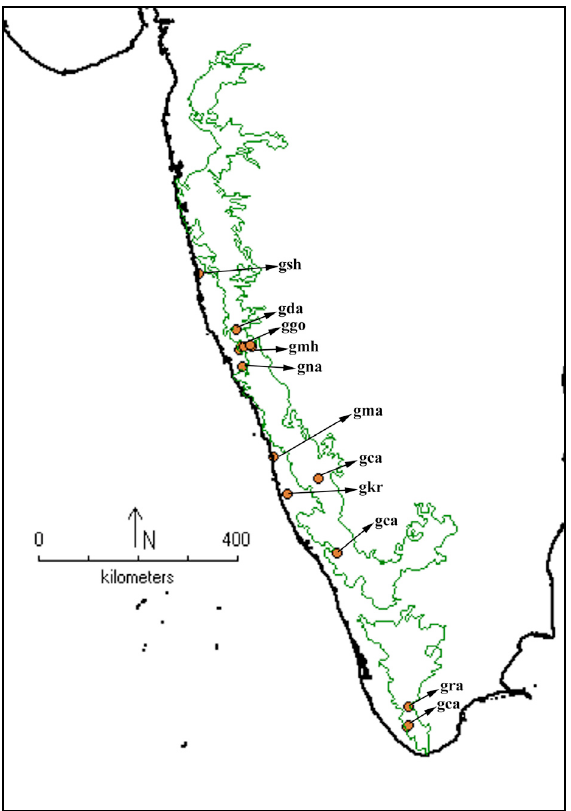
Figure 1. Distribution of species of Gegeneophis in Western Ghats gsh - Gegeneophis seshachari ; gda - Gegeneophis danieli ; ggo - Gegeneophis goaensis ; gmh - Gegeneophis mhadeiensis ; gna - Gegeneophis nadakarnii ; gma - Gegeneophis madhavai ; gca - Gegeneophis carnosus ; gkr - Gegeneophis krishni ; gra - Gegeneophis